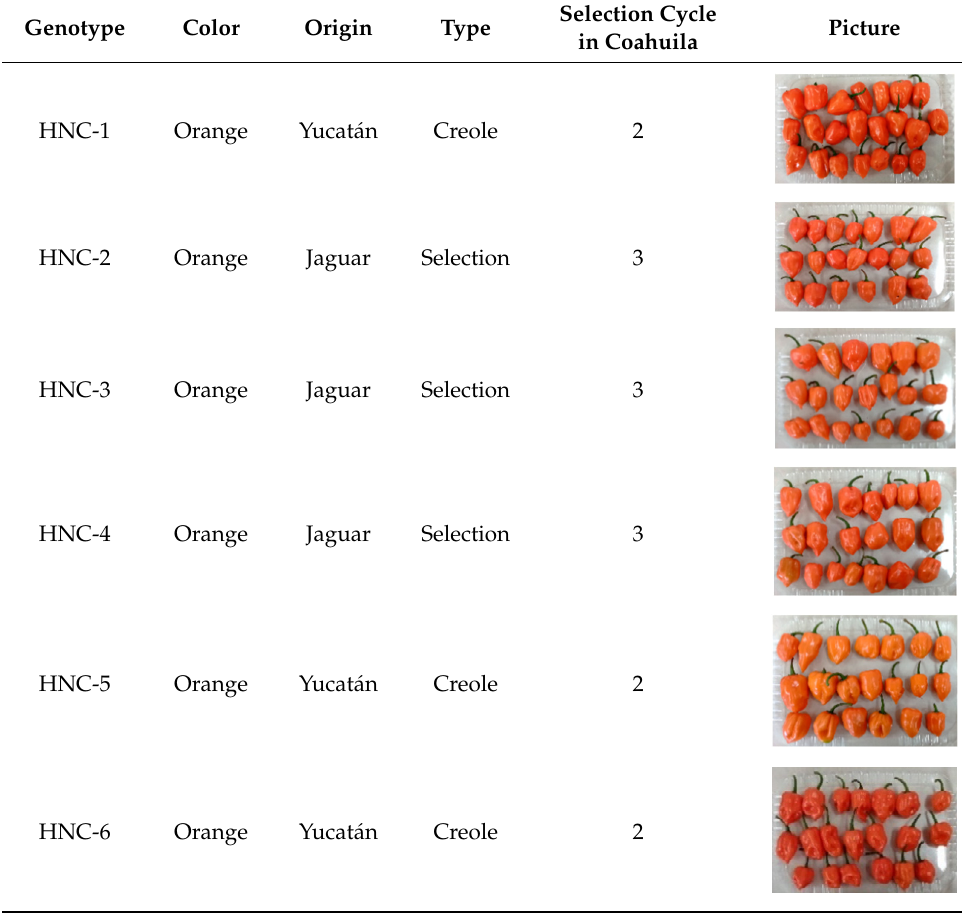
Table 1. Characteristics of the habanero pepper genotypes selected for the study. Genotype